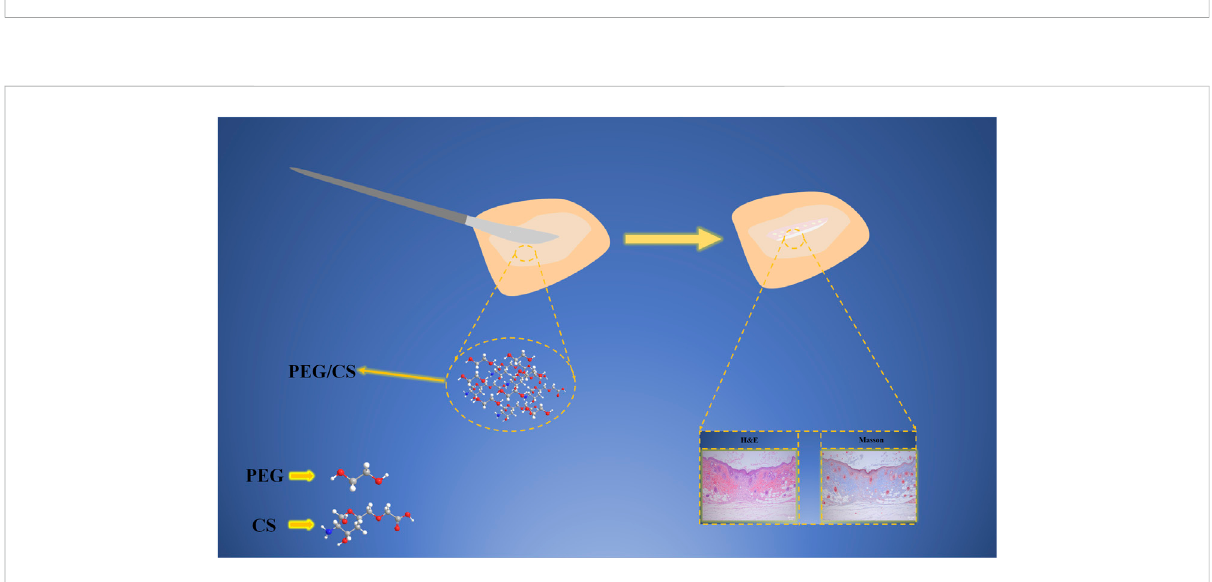
FIGURE 11 Wound-healing mechanism of the water-based PEG/CS composite